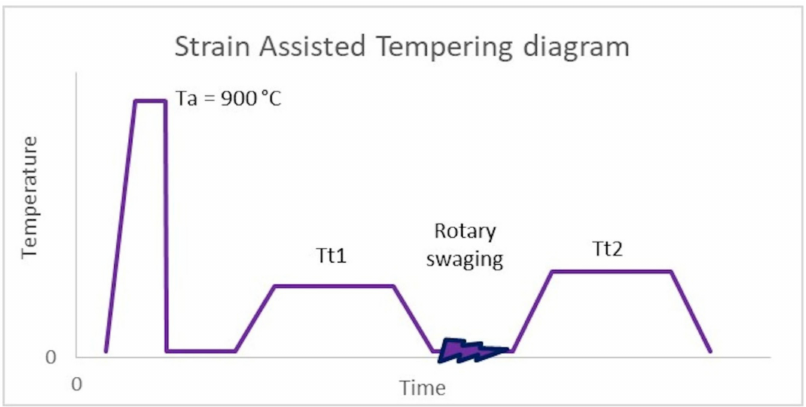
Figure 1. SAT diagram, Austenitization temperature (T a ), 1st tempering temperature (T t1 ), 2nd tempering temperature (T t2